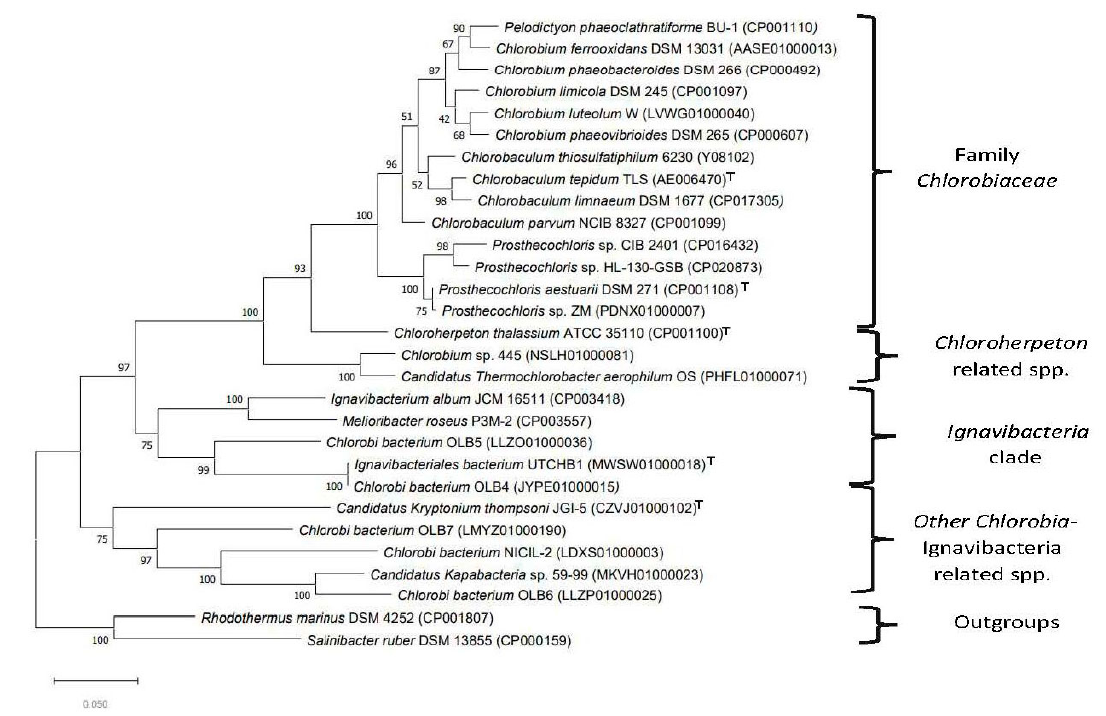
Figure 2. Maximum-likelihood phylogenetic tree based on 16S rRNA gene sequences for the type strains of all Chlorobi species. The tree was rooted using the sequences for S. ruber and R. marinus . Accession numbers of the 16S rRNA gene sequences are given within the bracket after species names in the tree. The main identified clades in this tree are marked.